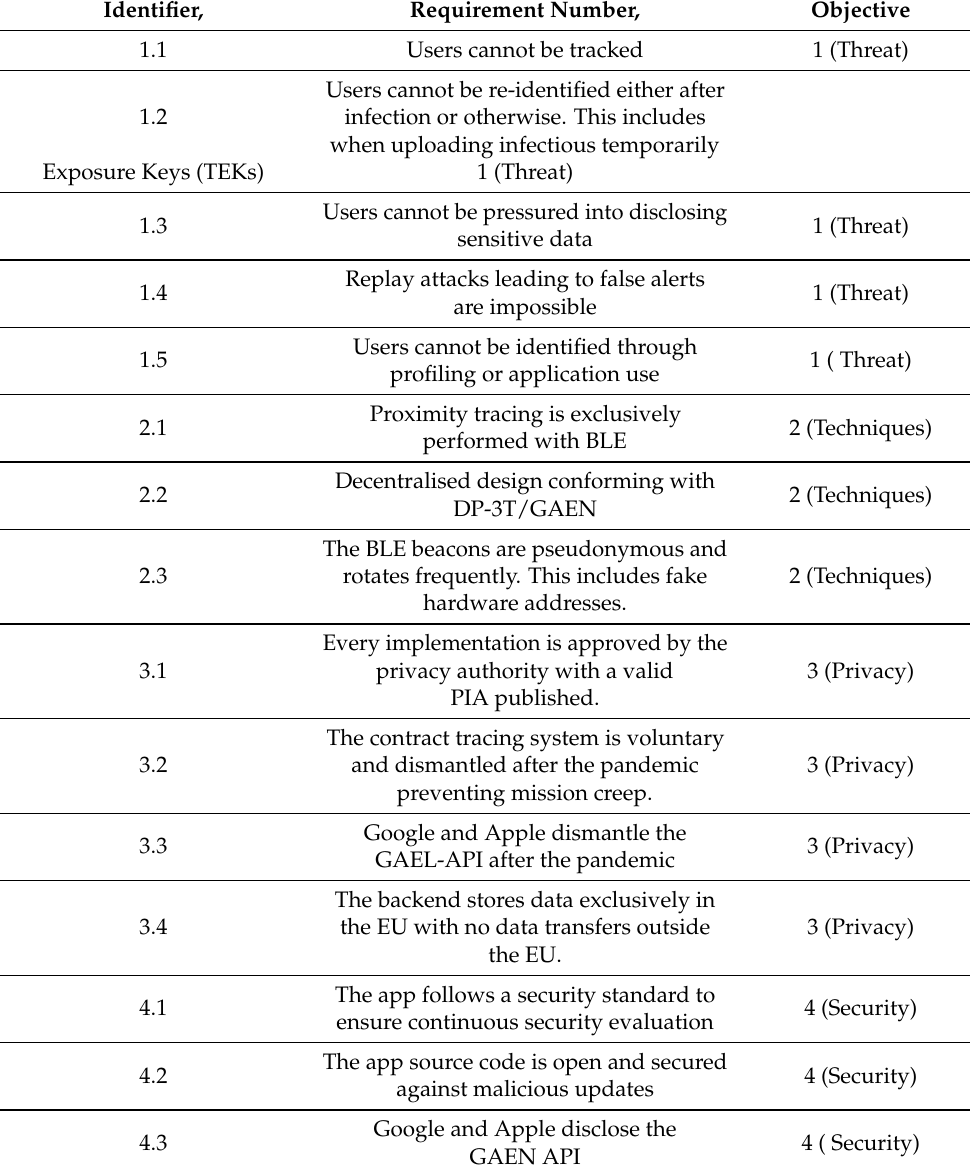
Table 2. Draft framework for privacy and